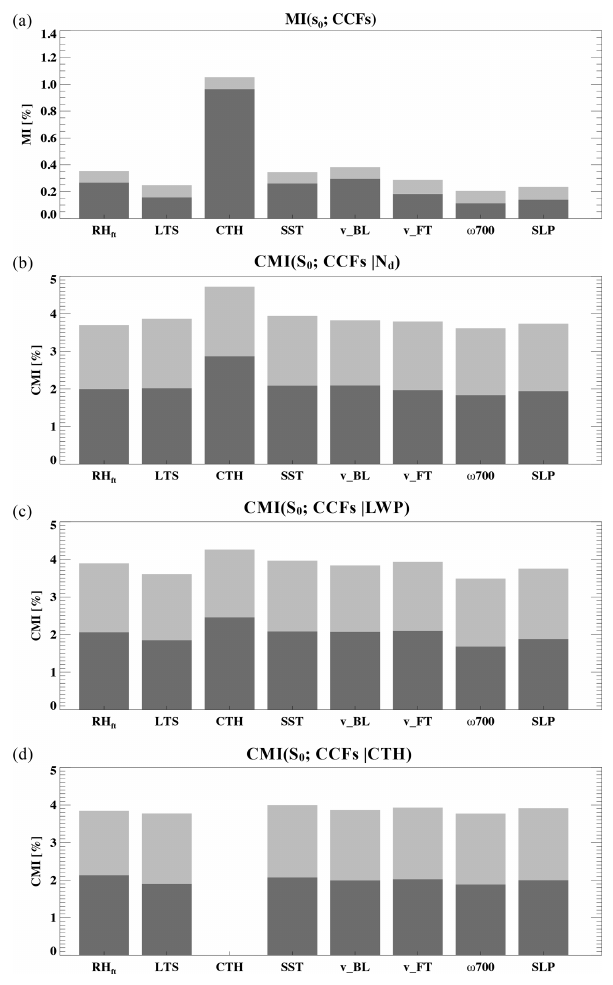
Figure 1. (a) Mutual information (MI; dark gray) for S 0 and eight meteorological factors (MFs; denoted as cloud controlling factors, CCFs), including RH ft , LTS, CTH, SST, BL, and FT winds, 700hPa vertical velocity ( ω 700), and sea level pressure (SLP). (b–d) Con- ditional MI (CMI; dark gray) for S 0 and the 8MFs, conditioned by N d , LWP, and CTH, respectively. Noise-CMI (light gray) is repre- sented by the (conditional) mutual information between MFs and randomly permuted S 0 sample space (effectively